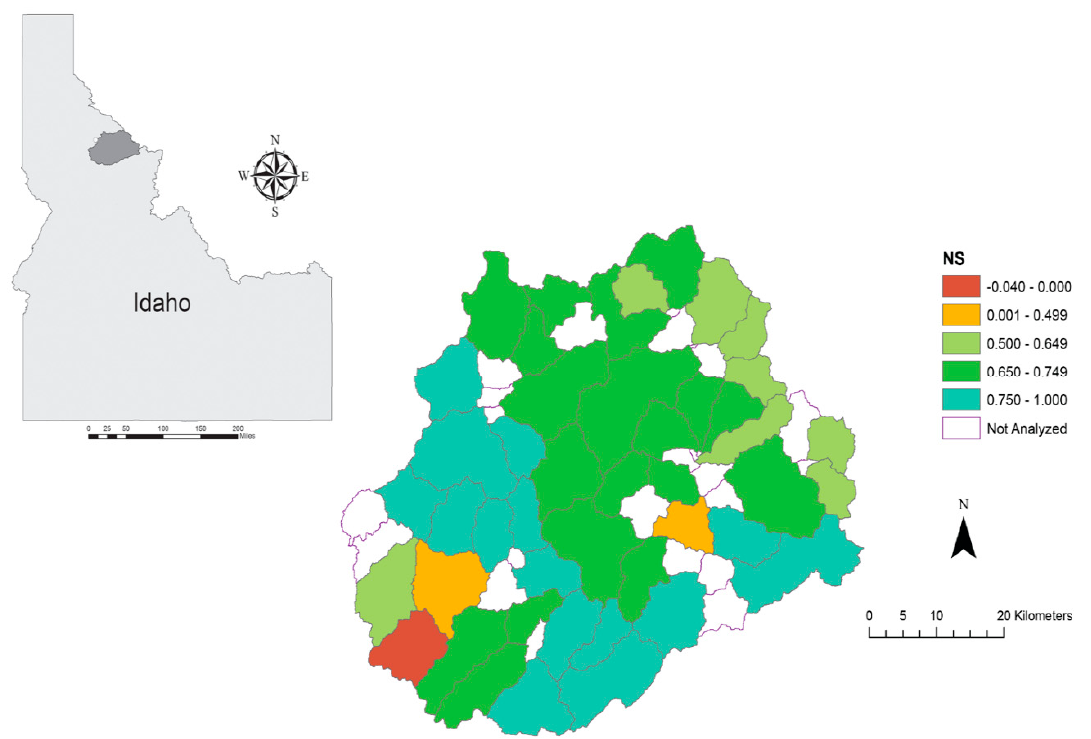
Figure 1. Locality map showing the position of the Upper North Fork basins in Idaho, USA. The larger map shows Nash Sufficliffe values within this watersheds sub-basin, based on comparison of simulated ET with the MODIS13A2v5 ET product (described below).